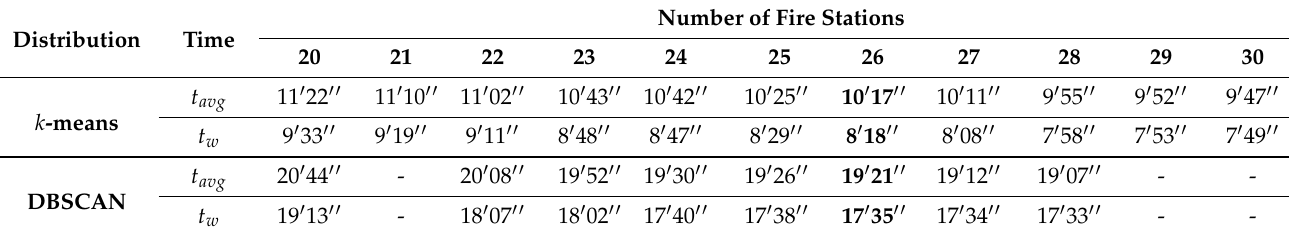
Table 1. Average and weighted times to reach a fire obtained with k -means and DBSCAN for different numbers of clusters between 20 and 30. Missing values for DBSCAN indicate that any optimized distribution was found with said number of clusters. Results with 26 clusters are highlighted in bold font to be compared with the existing distribution of stations (nowadays t avg = 12 (cid:48) 37 (cid:48)(cid:48) and t w = 10 (cid:48) 05 (cid:48)(cid:48)